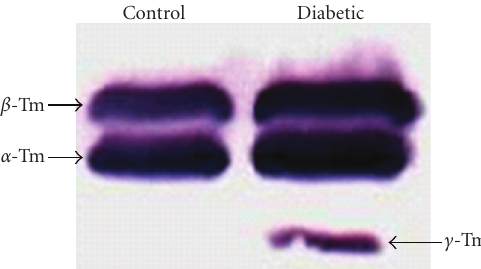
Figure 4: Expression of the slowest Tm isoform occurs in untreated DPH muscles after 8 weeks of diabetes. Western blot shows the control and diabetic expression patterns for all three Tm isoforms. The slowest Tm isoform is only detected in 8-week diabetic muscle homogenates. See experimental details in Section